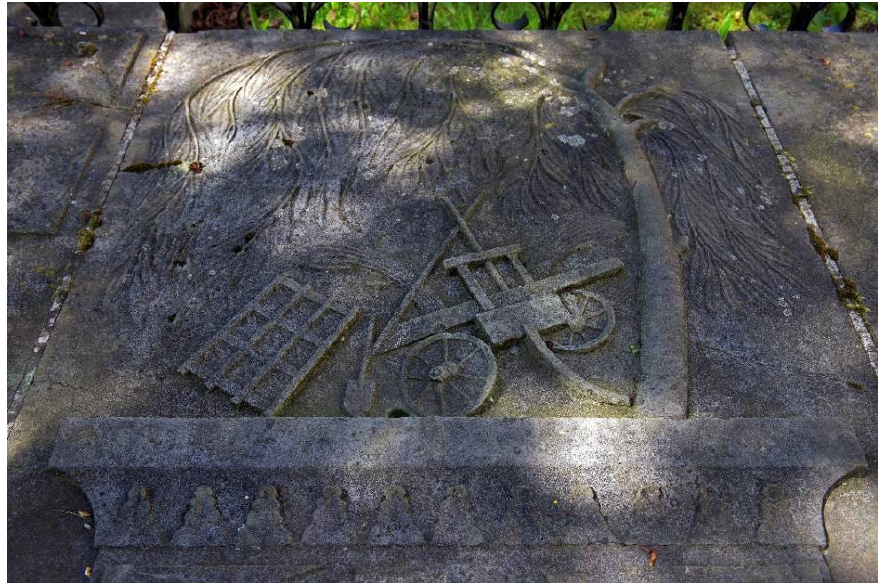
Figure 8. Zuurdijk (Groningen), tombstone of Jan Jakobs Bos (†1871) in the cemetery showing several farmers’ tools: harrow, spade, flail, and plough (photo: Jim Ernst).